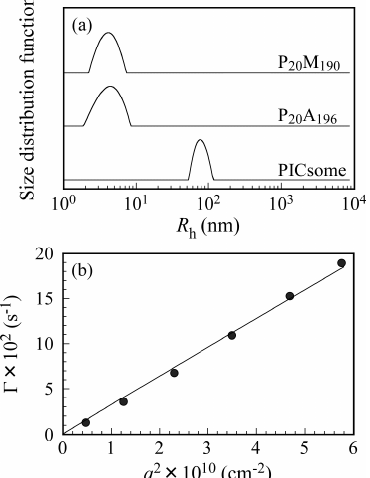
Figure 3. ( a ) Hydrodynamic radius ( R h ) distributions for P 20 M 190 , P 20 A 196 , and PICsome with f + = 0.5 in aq. 0.1 M NaCl at C p = 0.5 g/L and at scattering angle ( θ ) = 90°; ( b ) relation between relaxation rate ( Γ ) and square of the magnitude of the scattering vector ( q 2 ) for PICsome with f + = 0.5 at C p = 0.5 g/L.